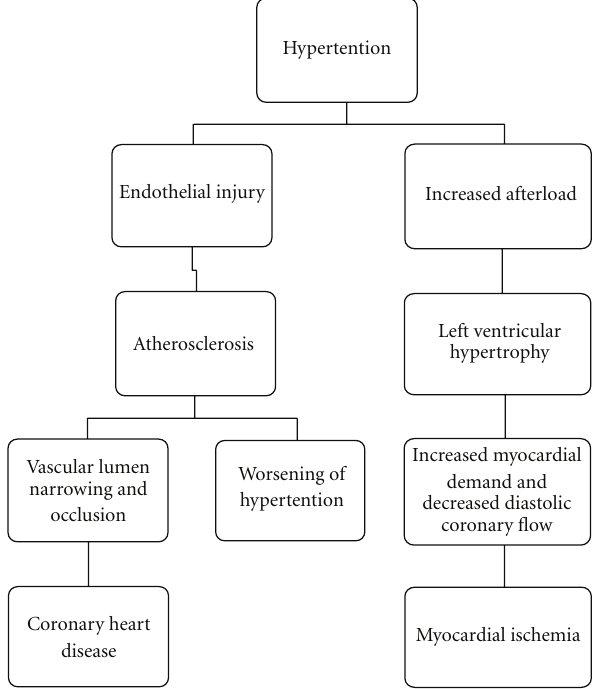
Figure 1: Pathophysiological link between hypertension and coro- nary heart